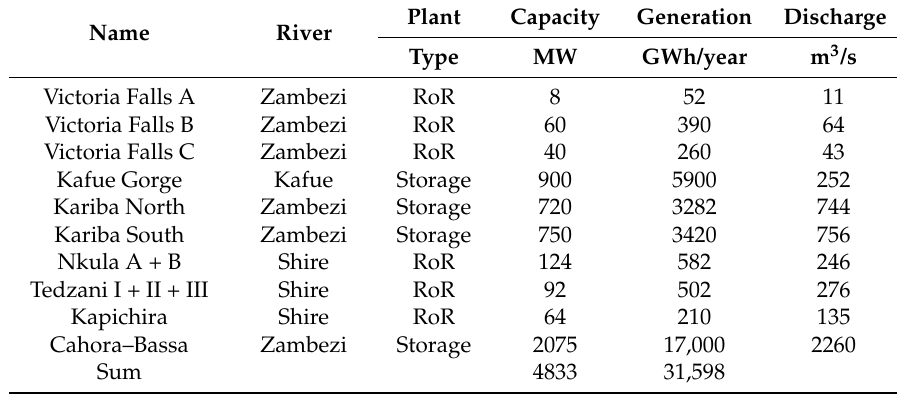
Table 2. List of existing hydropower plants and their characteristics within the studied part of the Zambezi River Basin.